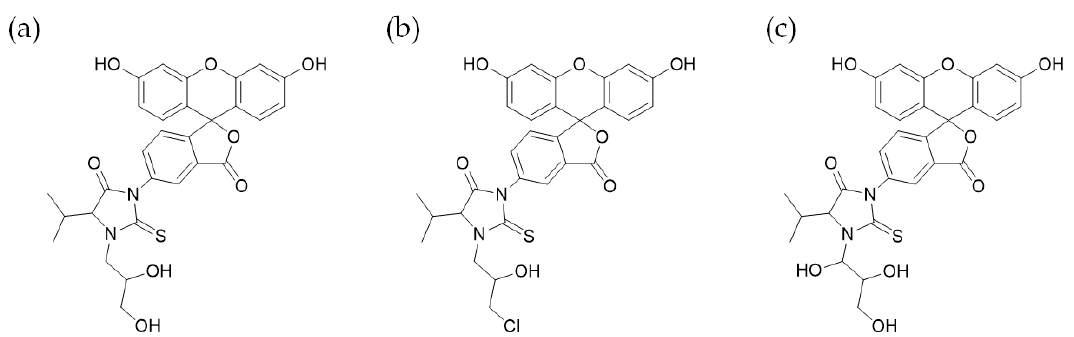
Figure 2. Structures of N -terminal valine adduct fluorescein isothiocyanate (FITC) derivative. ( a ) Glycidol-valine adduct FITC derivative, ( b ) epichlorohydrin-valine adduct FITC derivative, and ( c ) glyceraldehyde-valine adduct FITC derivative. An Edman reagent, FITC, is added to L-valine and glycidol, epichlorohydrin, or glyceraldehyde. N -terminal valine adducts are derivatized and detached as adduct derivatives, fluorescein thiohydantoins.